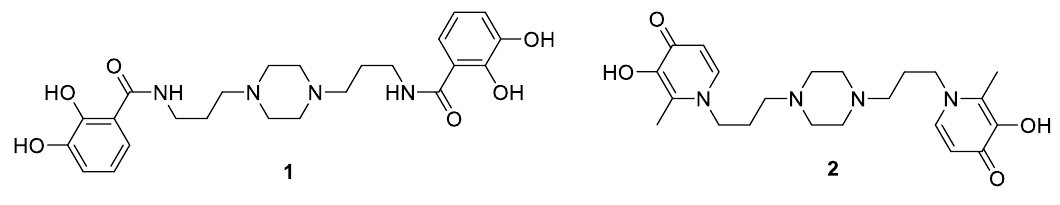
Figure 1. Chemical structure of siderophore mimetics.